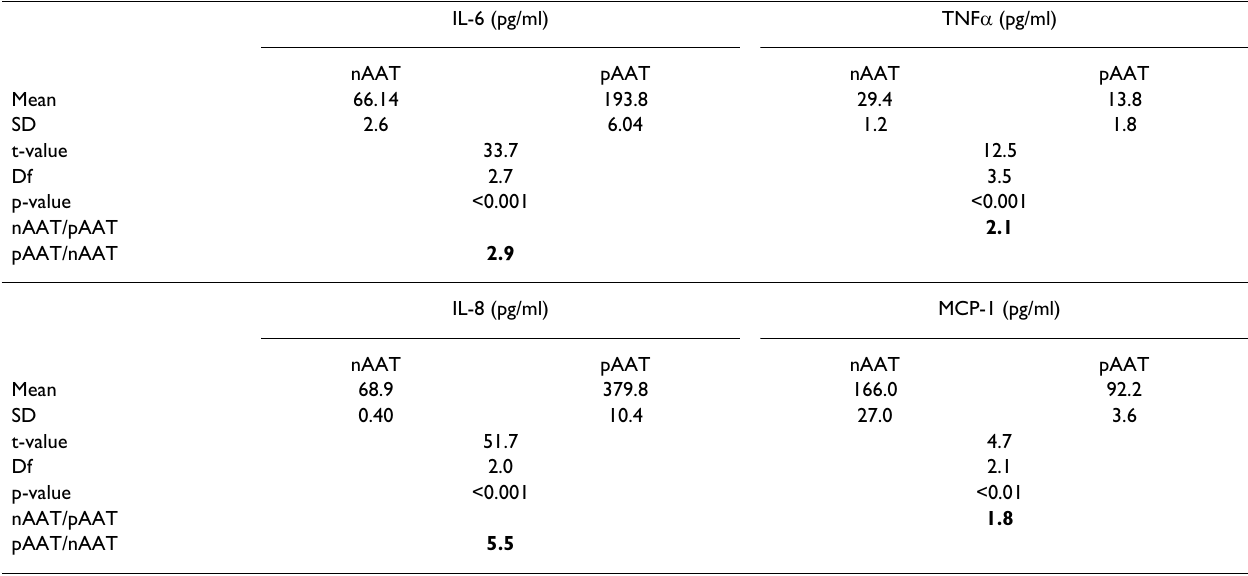
Table 1: A comparison between native (nAAT) and polymerised (pAAT) α 1-antitrypsin (0.1 mg/ml) effects on cytokine and chemokine